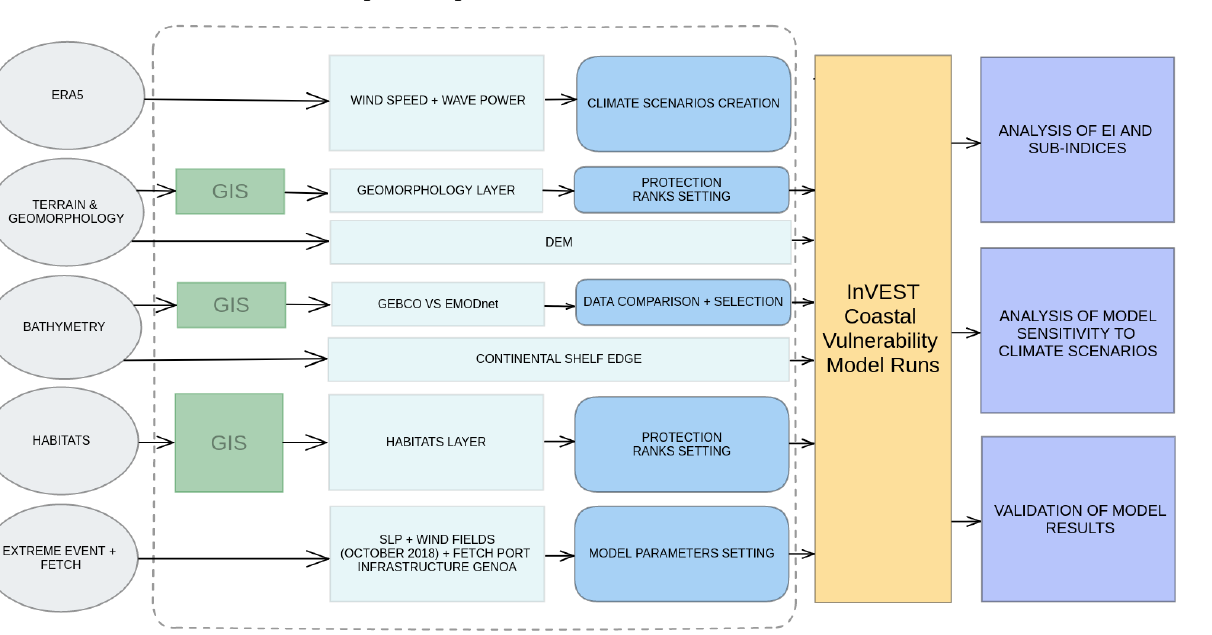
Figure 2. Case study workflow. Grey ellipses represent the main categories of data sources. Data for which a pre-processing has been carried out in a GIS environment (geomorphology and habitat data for data selection and shapefile creation, bathymetry data for quality comparison within the AOI) are connected to the corresponding green rectangles. The main data pre-processing, data selection, parameters setting and scenario creation steps are summarised in the middle part of the workflow (delineated by a dotted perimeter). The three main data analysis steps carried out on model results are pictured as dark blue rectangles on the right of the workflow